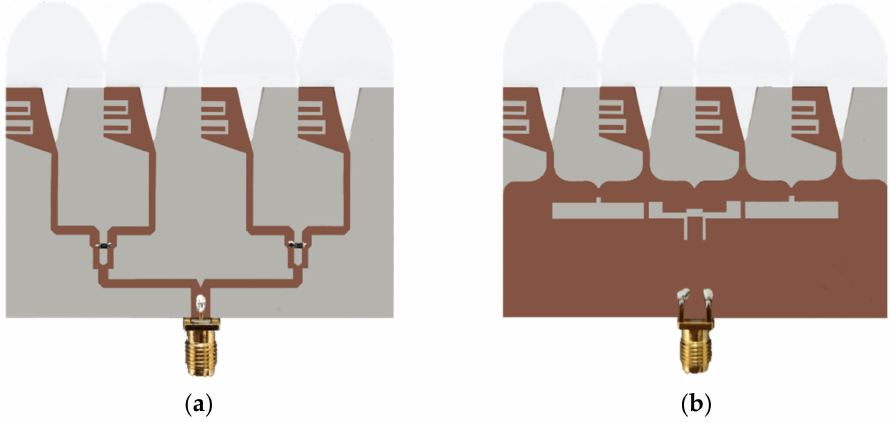
Figure 16. Photograph of the fabricated antenna array with DGS, ( a ) front view and ( b ) back view.